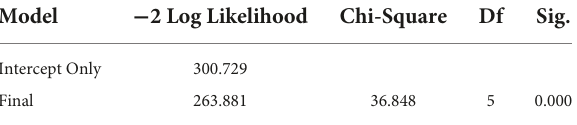
TABLE 8 Model fitting